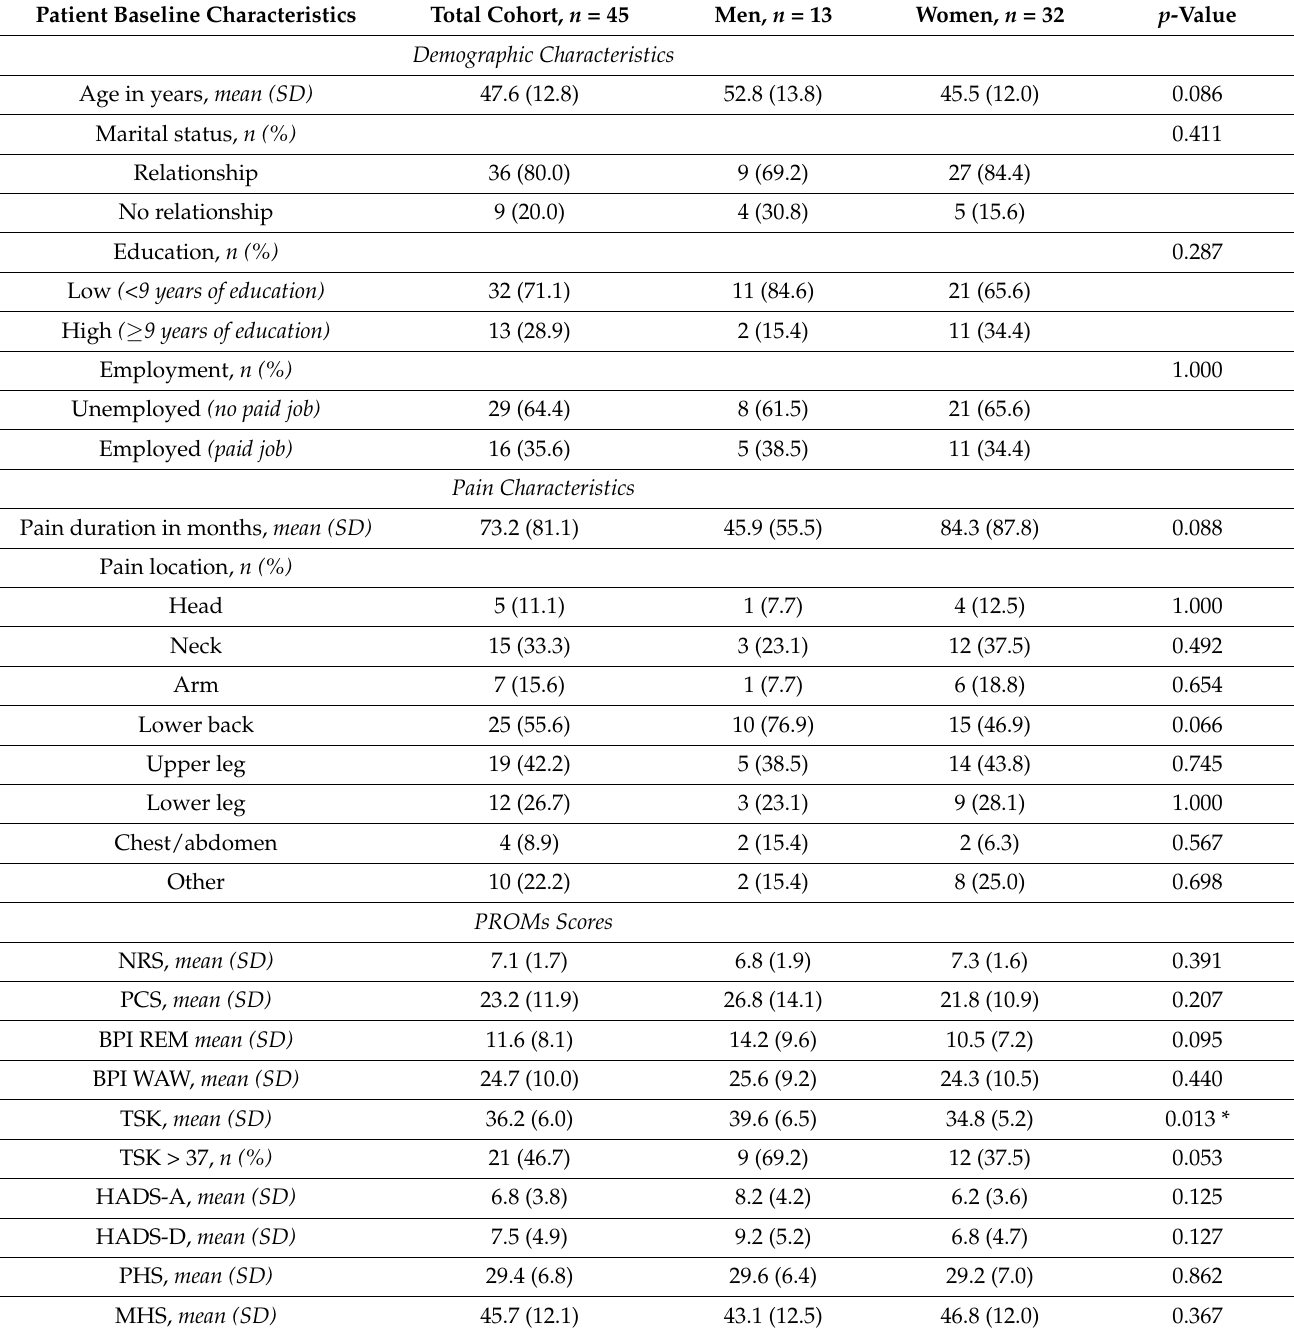
Table 1. Baseline description of the chronic pain patient